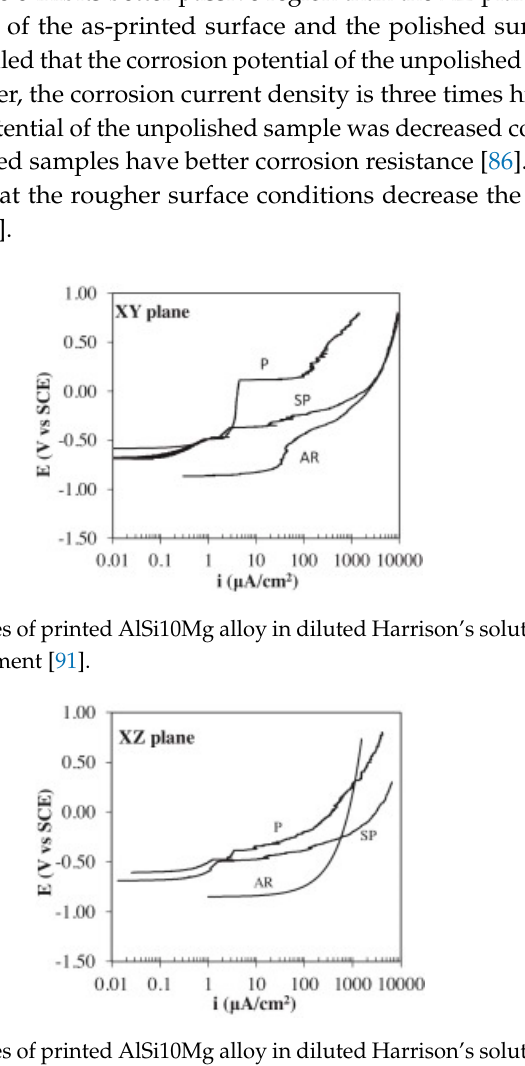
Figure 6. The polarization curves of printed, ground and casted aluminum alloy produced by DMLS [90].